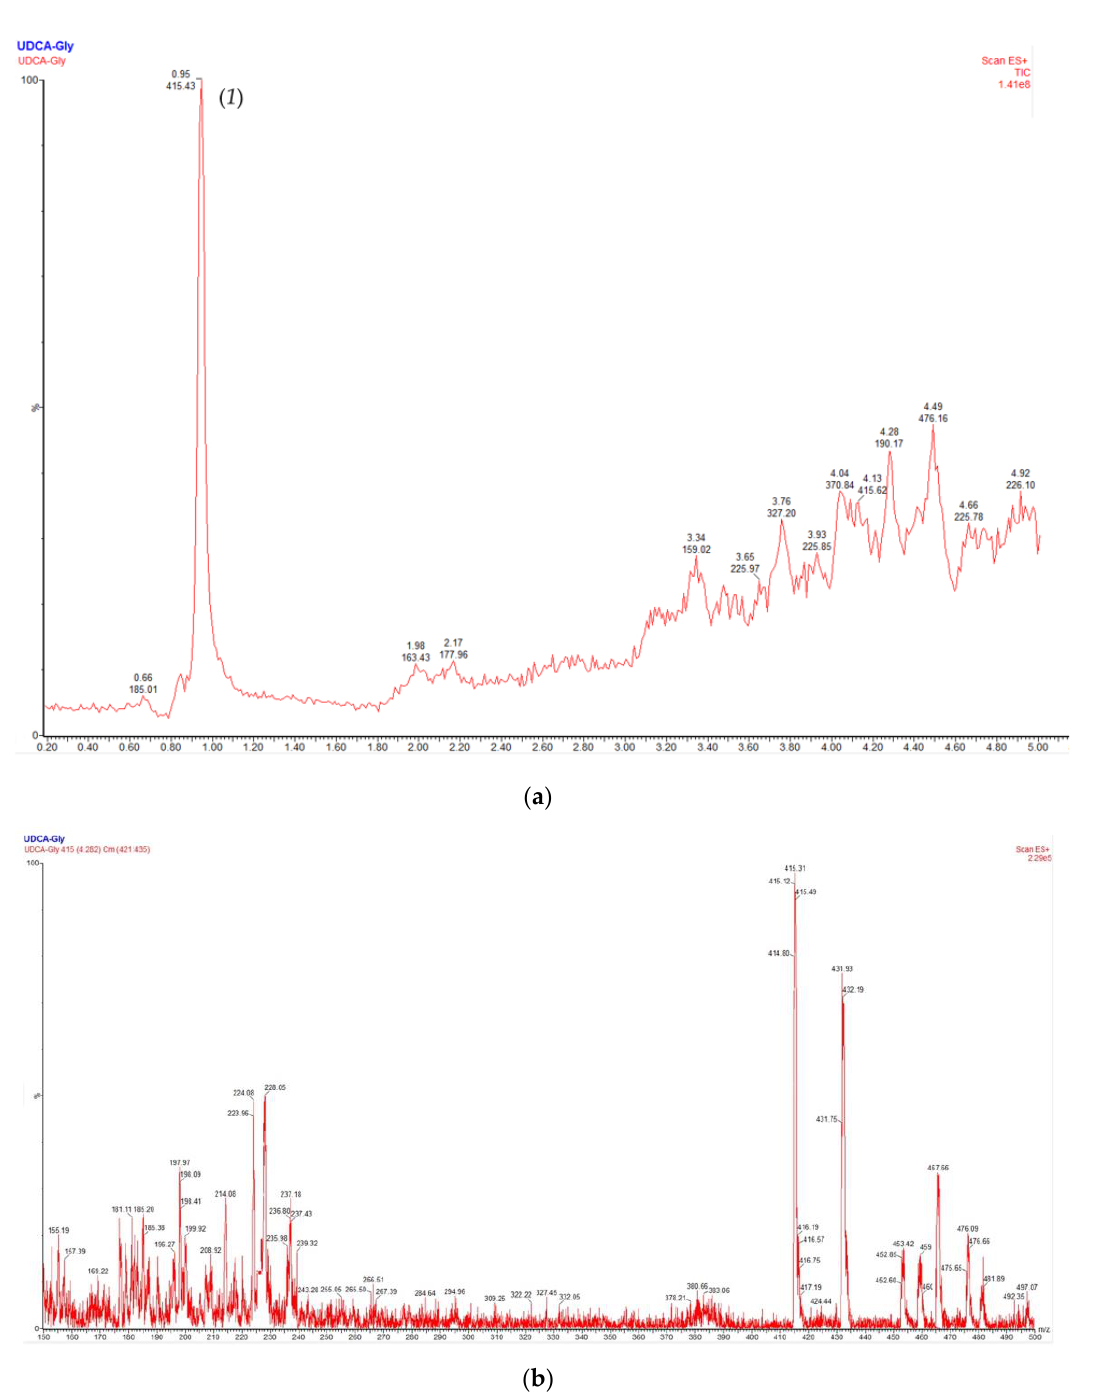
Figure 6. uHPLC–MS analysis of lipase-catalyzed esterification of UDCA and glycerol by N435. ( a ) uHPLC chromatogram, showing the peak of UDCA-monoglyceride (peak No. 1) at 0.95 min; ( b ) ESI+/MS spectrum of the peak No. 1, showing the ester product by electrospray ionization mass spectroscopy.